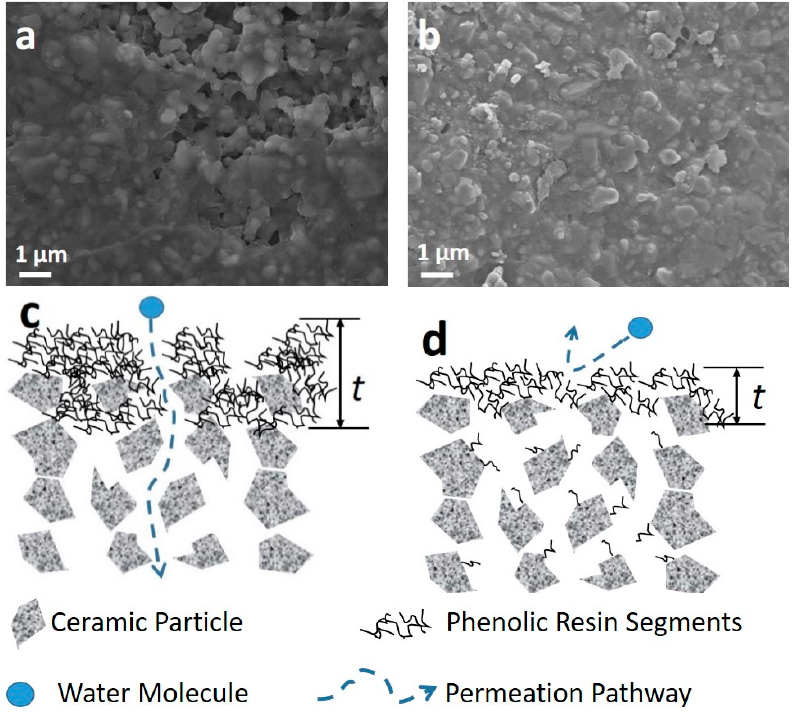
Figure 4. Representative SEM images of the surface of carbon alumina S-C membranes prepared at vacuum-assisted impregnation times of ( a ) 30 s and ( b ) 600 s, and respective idealized membrane structural schematic ( c ) 30 s and ( d ) 600 s and the phenolic resin thickness ( t ).